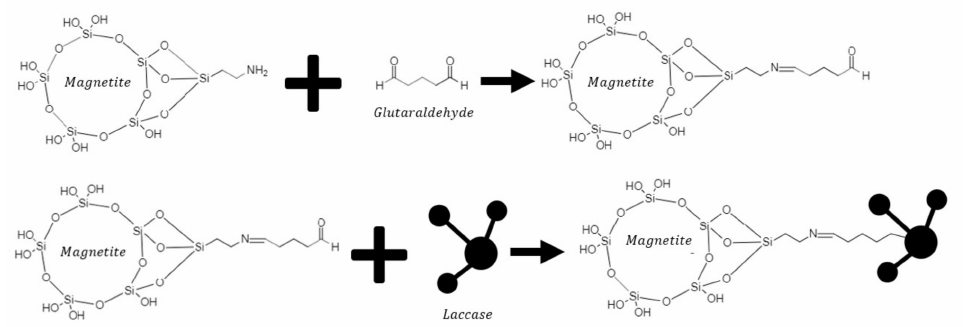
Figure 1. Reaction mechanism for enzyme immobilization. Upper panel shows the silaniza- tion with APTES and later crosslinking of NH 2 terminal groups with the aid of glutaraldehyde. Bottom panel shows the conjugation of laccase by forming imine bonds with the pre-activated magnetite